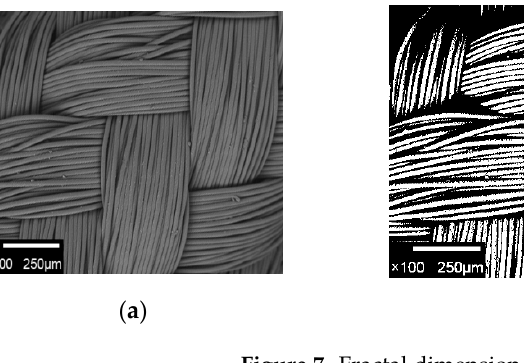
Figure 7. Fractal dimension results of woven fabric: ( a ) SEM image, ( b ) image after pretreatment, and ( c ) fractal dimension calculation.